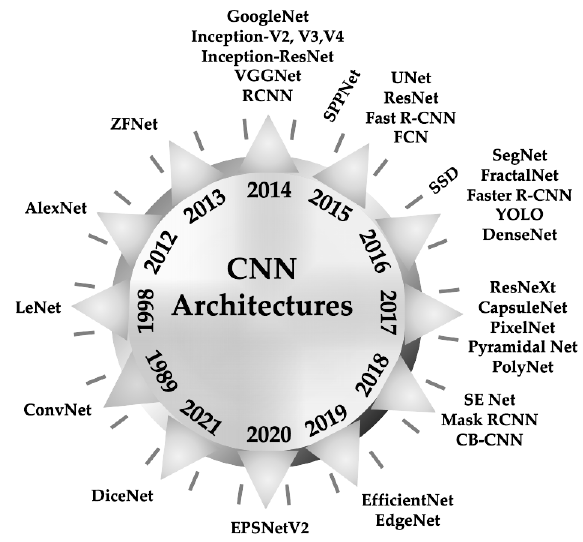
Figure 8. CNN architecture evolution.